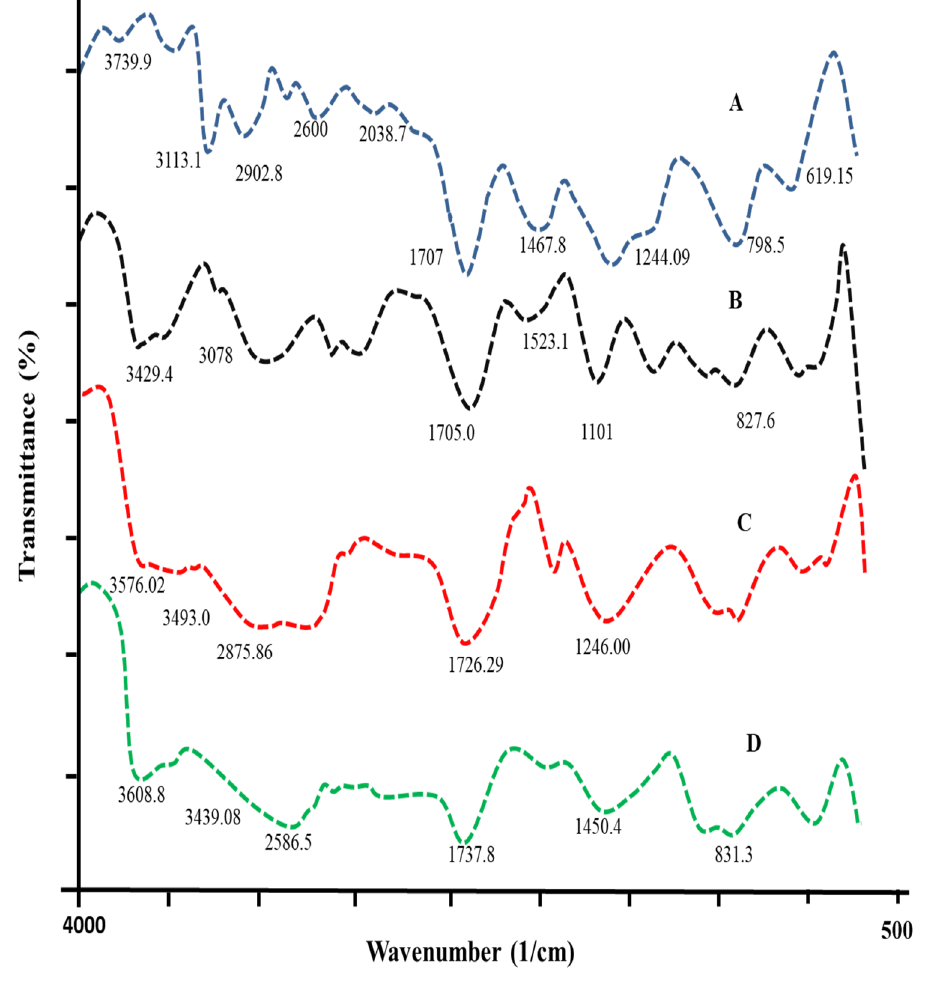
Figure 5. FTIR spectra of ( A ) Diloxanide Furoate, ( B ) Na-Alg, ( C ) Carbopol-934P, and ( D ) DF-loaded Na-Alg/CP –co-poly (methacrylate) hydrogels.